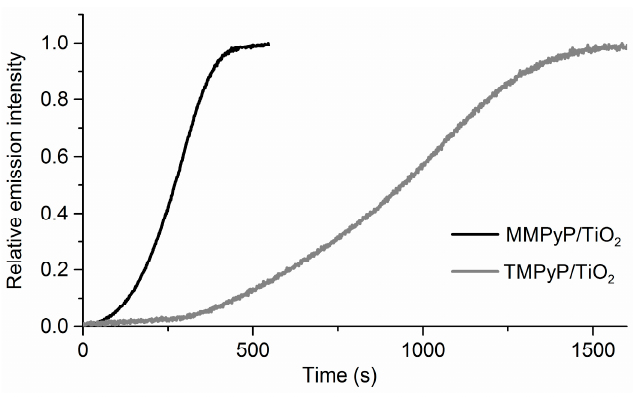
Figure 4. Normalised kinetic response at 660 nm of the protonated MMPyP/TiO 2 (black line) and TMPyP/TiO 2 (grey line) composites to 600 ppm of ammonia vapours.